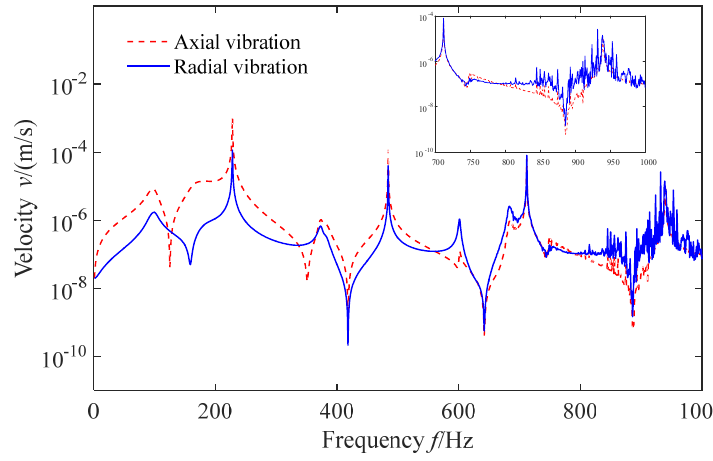
Figure 17. Calculation results overflow error example (case 1, point A).